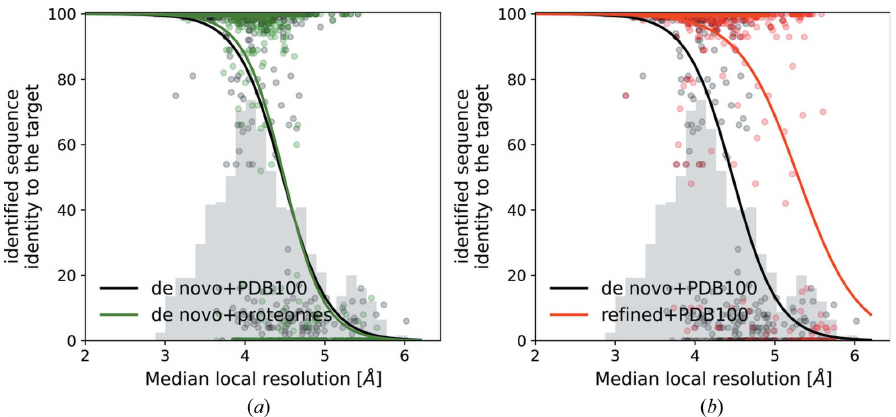
Figure 3 Sequence-identification benchmarks for 909 cryo-EM models of ribosomal proteins. ( a ) Comparison of the method performances for an identification of models built de novo against small (proteomes) and large (PDB100) sequence databases. ( b ) Comparison of the method performances for models built de novo and those based on refined deposited coordinates. Histograms of the median local resolution of the test-set proteins are shown in grey (in arbitrary units). The continuous curves are logistic regression estimates of a probability that an identified sequence will have at least 80% sequence identity to the target